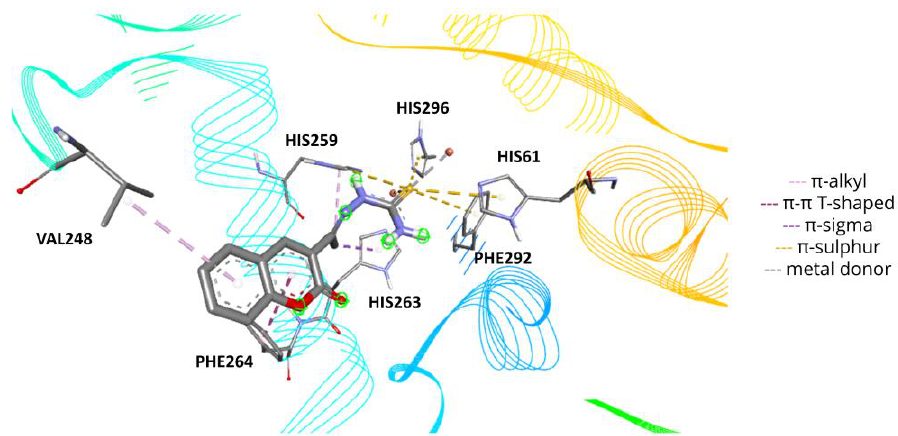
Figure 5. Docked pose of T1 in the catalytic MTa site and intermolecular interactions with the surrounding residues of mushroom tyrosinase.